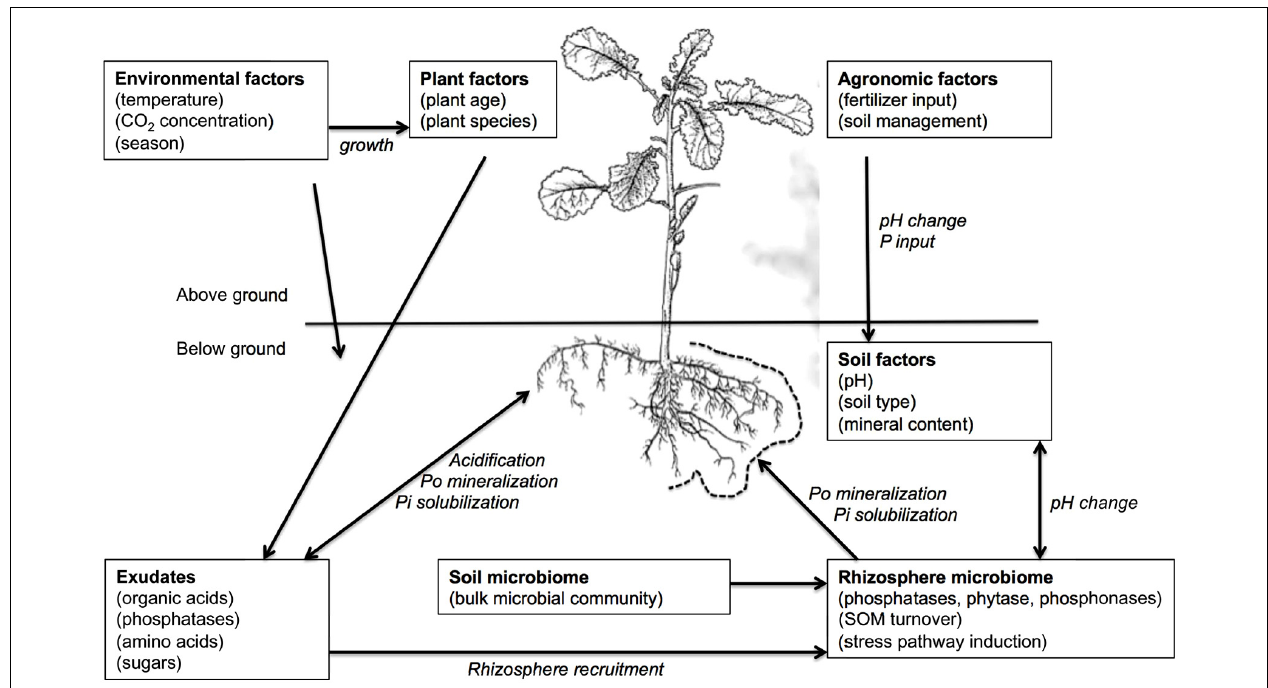
FIGURE 1 |The various influences on P acquisition of plant root systems and their potential